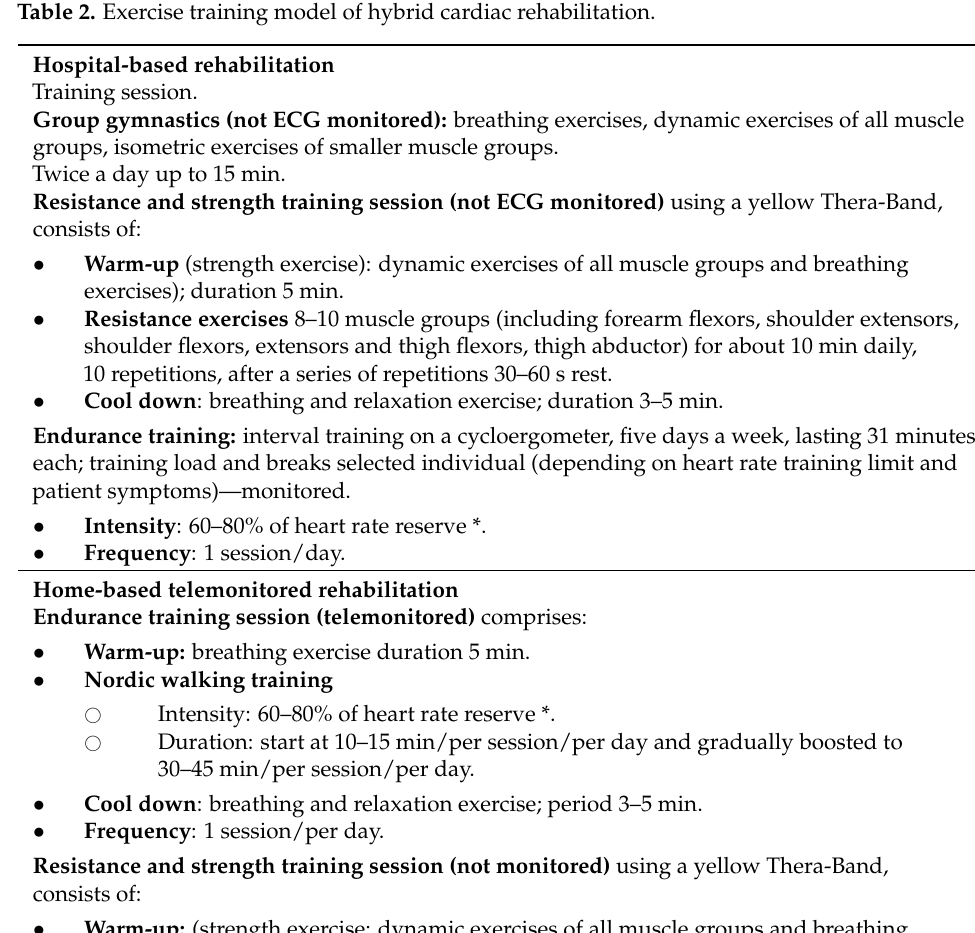
Table 2. Exercise training model of hybrid cardiac